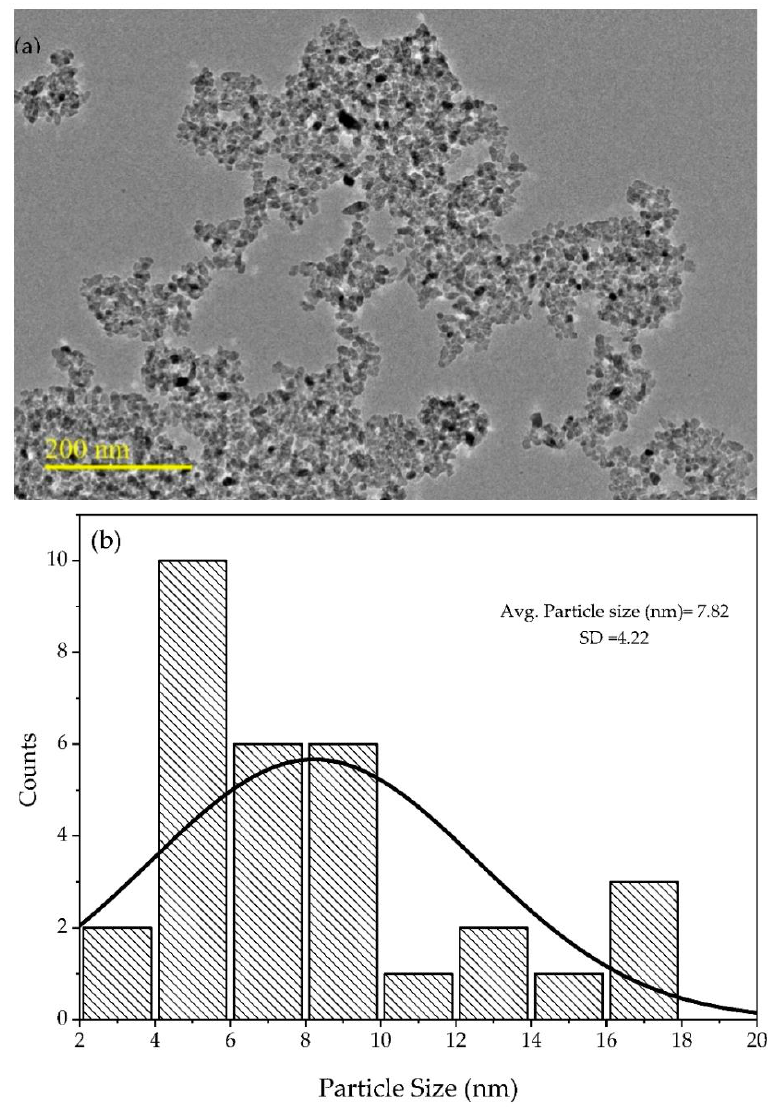
Figure 5. ( a )TEM micrographs and ( b ) size distribution histogram of 0.1Fe-TiO 2 -300.